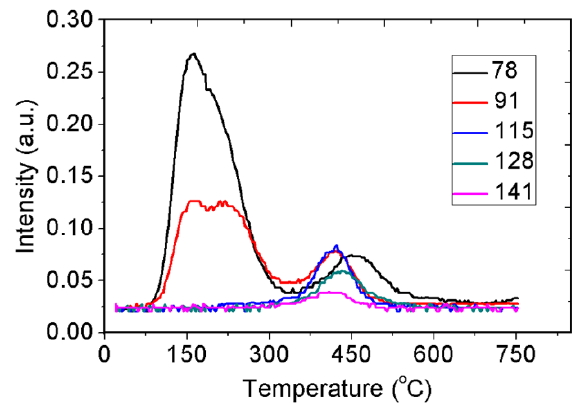
Figure 9. TPD-curves for the molecular and/or fragment ions of aromatics with m / z 78 (benzene), 91 (tropylium ion, C 7 H 7 + ), 115 (indene), 128 (naphtalene), and 141 (methylnaphtalene).